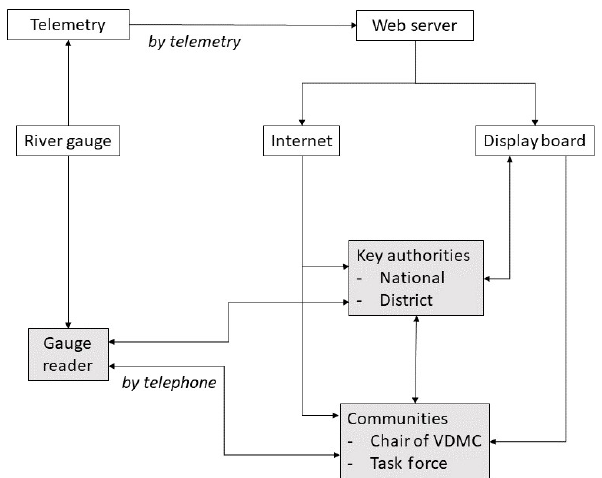
Figure 2. Early warning communication chain including telemetry system and actors (in grey) (from Practical Action,